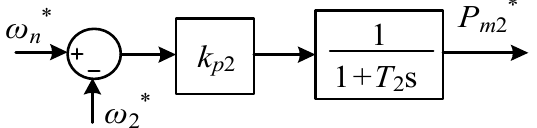
Figure 3. The governor diagram of synchronous generator. According to Figure 3, the mechanical active power P m 2 * of SG satisfies